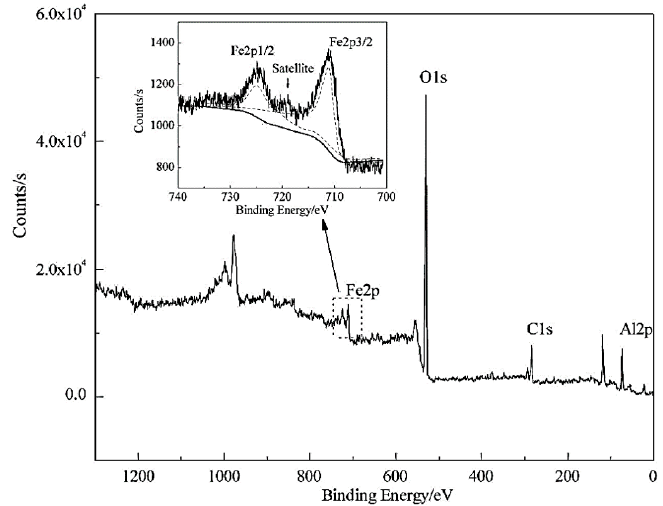
Figure 3. XPS spectrum of Fe/ γ -Al 2 O 3 (inset: high resolution XPS of Fe 3+ ).